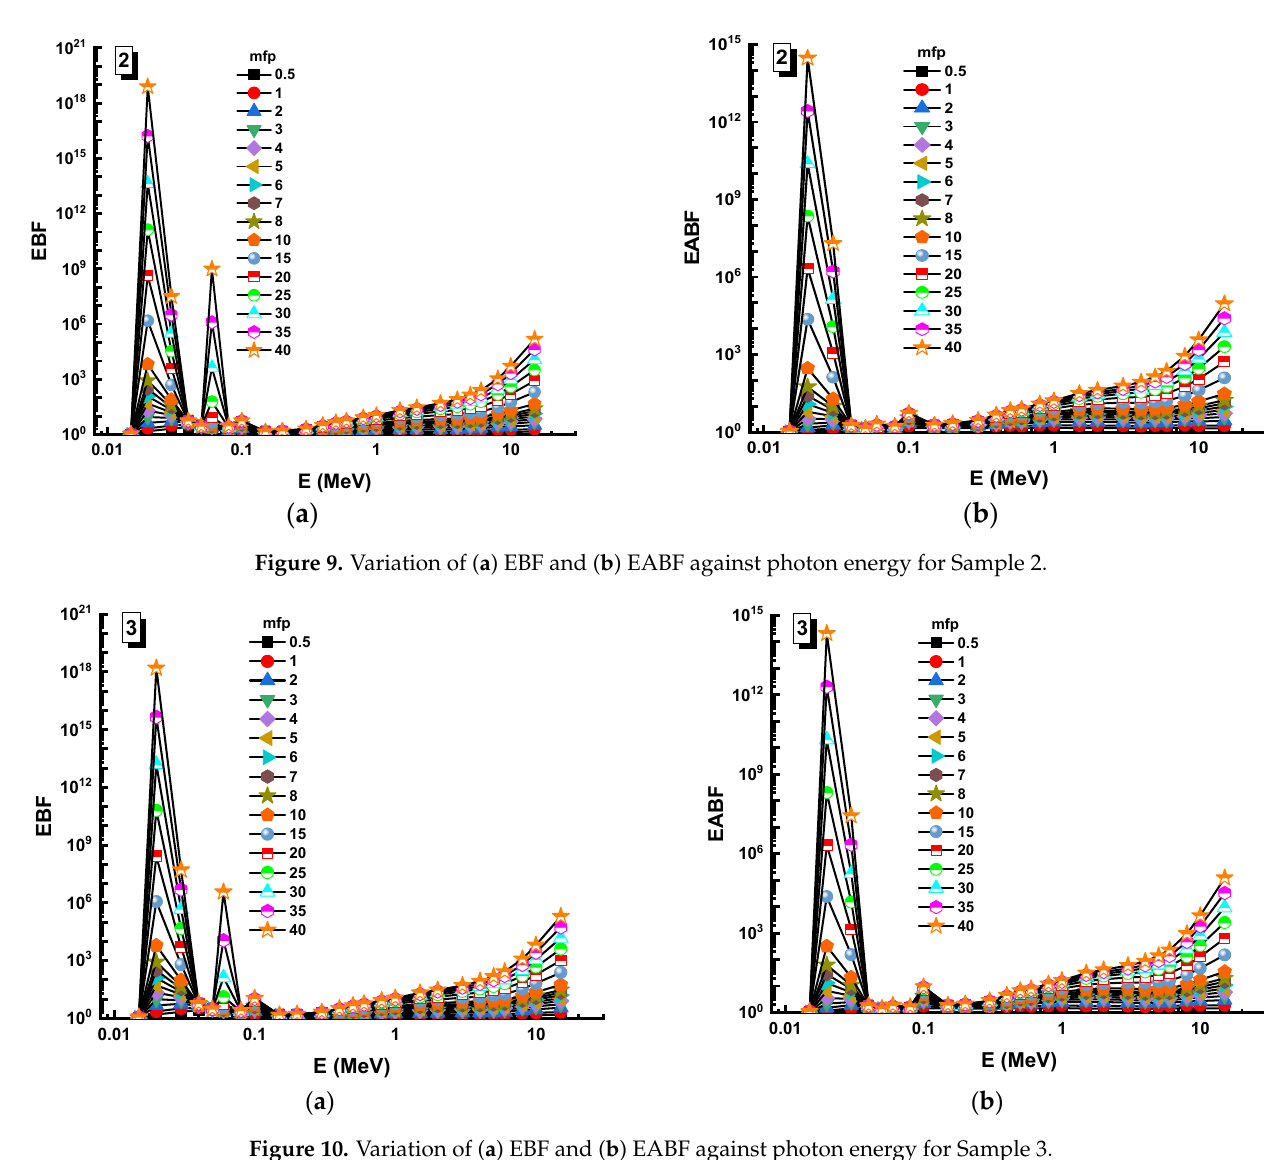
Figure 8. Variation of ( a ) EBF and ( b ) EABF against photon energy for Sample 1.